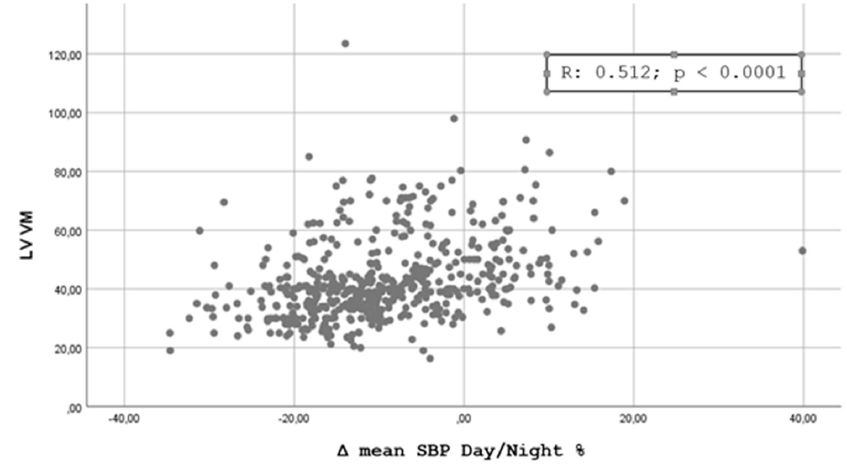
Figure 1. Scatterplot showing the Pearson’s correlation analysis for nocturnal reduction of blood pressure and Left Ventricle RWT.